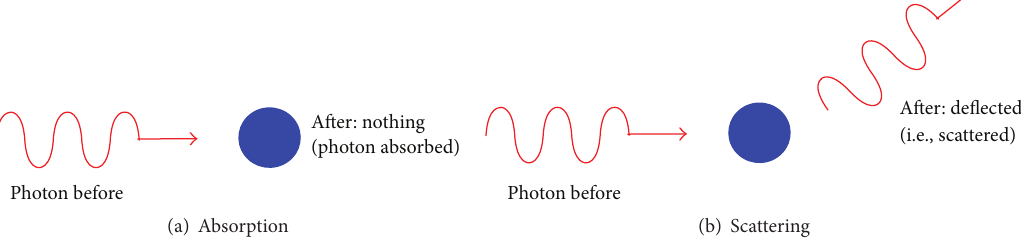
Figure 2: Microscopic view of (a) absorption of a photon by an absorber (represented by the blue circle) and (b) scattering of a photon by a scatterer (blue circle). See text for details.